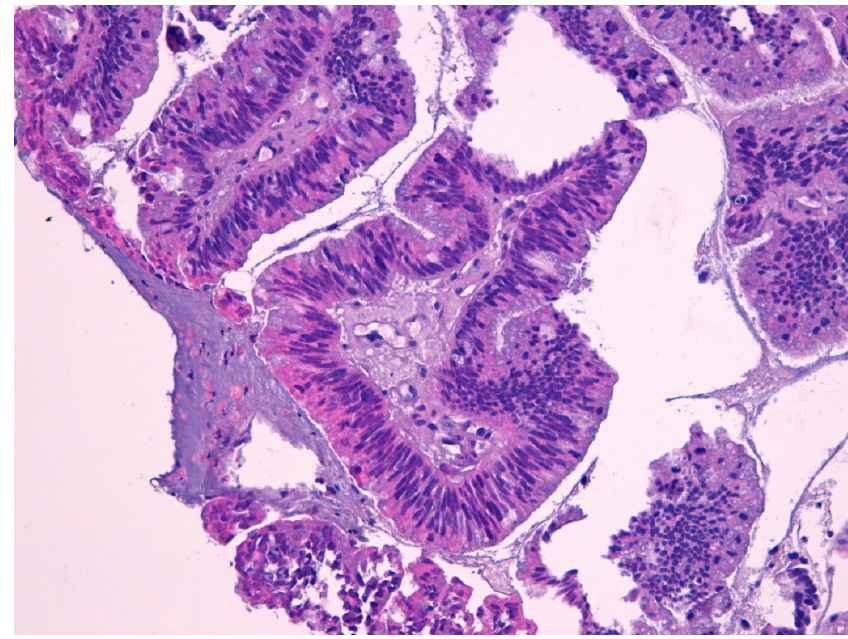
Figure 2 . Intestinal type adenocarcinoma (40×) stained with hematoxylin-eosin . Figure 2. Intestinal type adenocarcinoma (40 × ) stained with